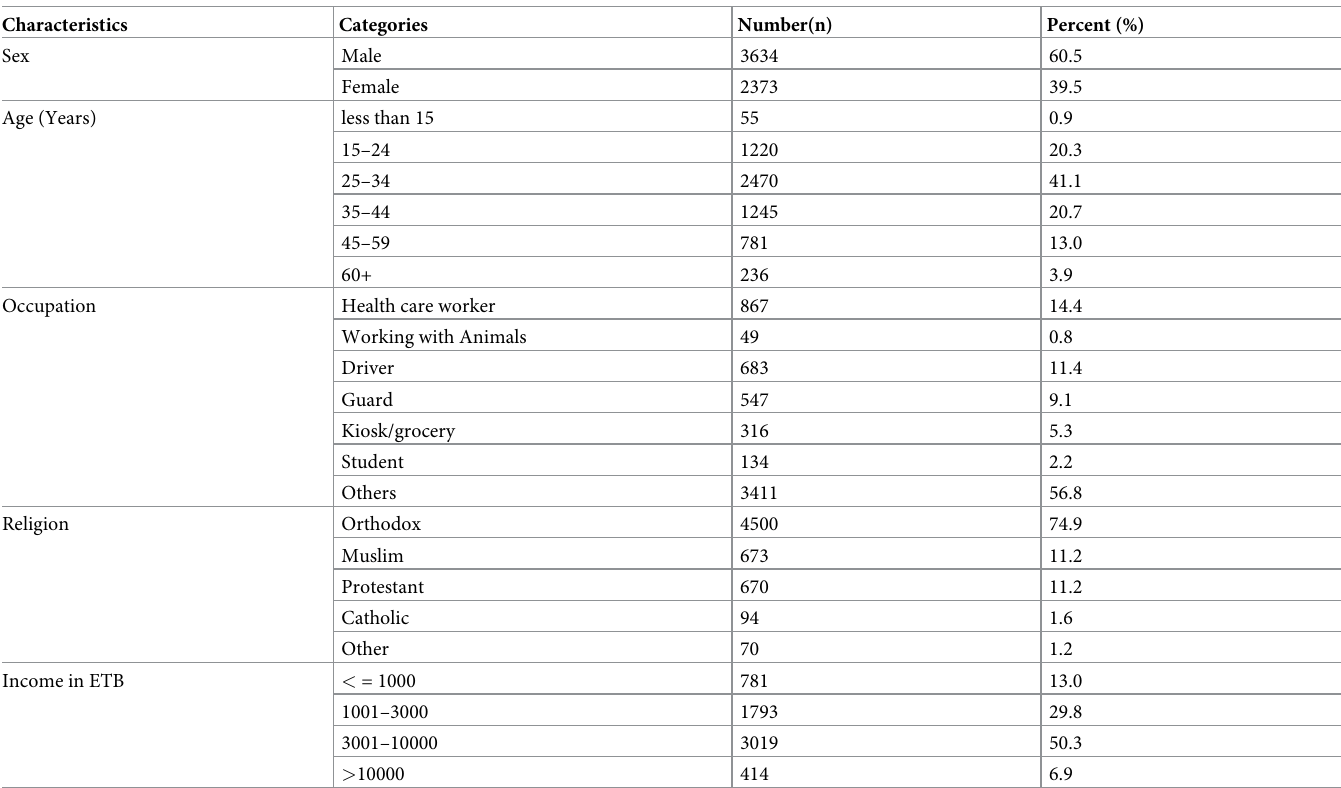
Table 1. Socio-demographic characteristics of the study participants, Addis Ababa, Ethiopia, 2020 (n = 6,007).